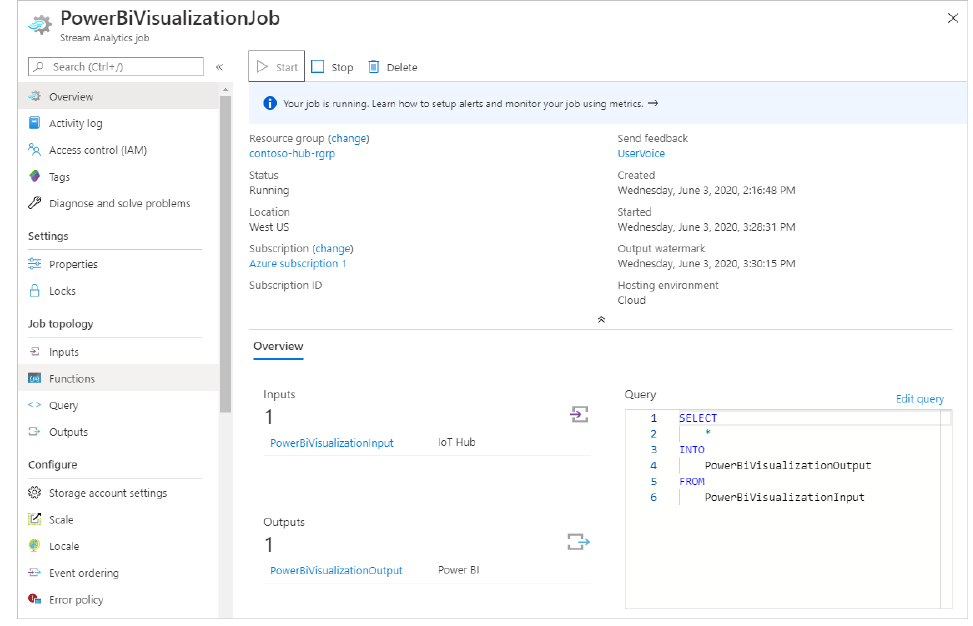
Figure 8. Power BI visualization job of real-time sensor data from the IoT Hub (https://docs.microsoft.com/pt-pt/azure/iot-hub/iot-hub-live-data-visualization-in-power-bi), accessed on 17 April 2021.